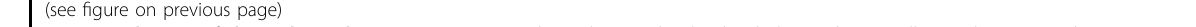
Fig. 2 Localisation of electrodes and active contacts. DBS electrodes were localised with the Lead-DBS toolbox and represented in common ICBM 2009b nonlinear asymmetric space incorporating a 7-Tesla MRI at 100 micron resolution 73 with subcortical parcellations derived from a recent high- resolution atlas 74 . A Three-dimensional reconstruction in the coronal plane showing electrode trajectories for the nine participants. B Three- dimensional reconstruction in the axial plane showing the distribution of the aggregated stimulation fi eld across the cohort (red), which can be seen to encompass the posterior segment of the nucleus accumbens (light green), the ventral pallidum (yellow) and the hypothalamus (blue). C Two- dimensional reconstruction of active contacts in coronal plane. D Two-dimensional reconstruction of active contacts in axial plane. E , F Two- dimensional reconstruction of active contacts in sagittal plane. In the two-dimensional representations, coloured circles represent the second most inferior contact on each electrode (i.e. contact 9 on right electrode and contact 1 on left electrode). Ca caudate, EXA extended amygdala (BNST), GPe globus pallidus external segment, HTH hypothalamus, NAC nucleus accumbens, PBP parabrachial pigmented nucleus, Pu putamen, SN substantia nigra, STH subthalamic nucleus, RN red nucleus, VeP ventral